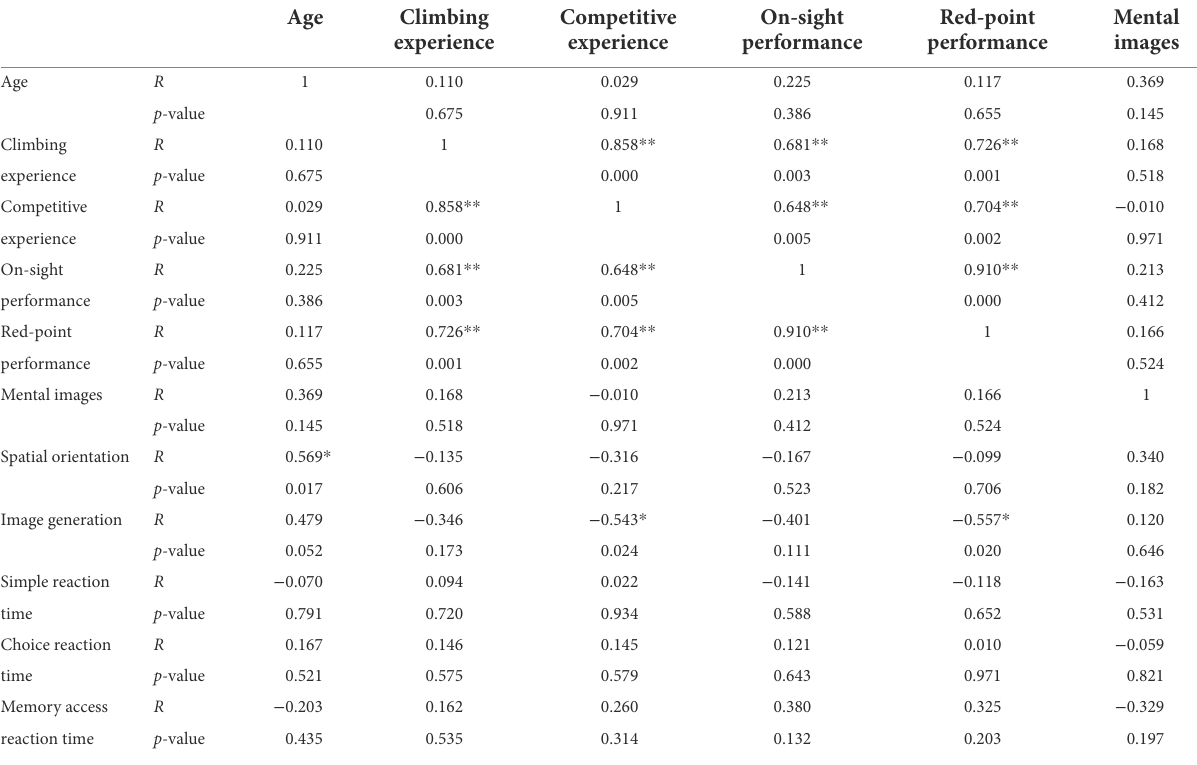
TABLE 2 Correlation